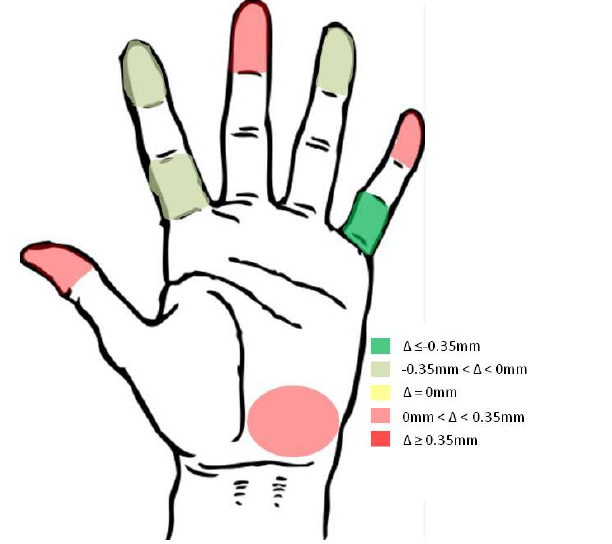
Fig. 7. Average “without glove” changes at each test site, pre to post training (smaller/greener values show improvement).